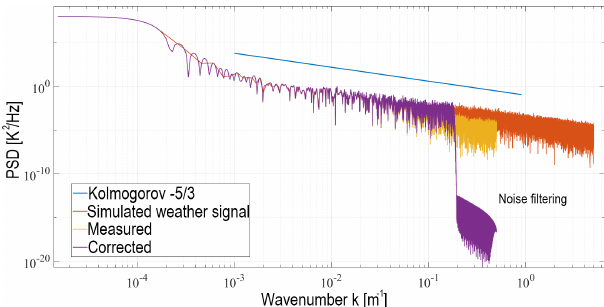
Figure 8. Power spectral density of the simulated weather signal in CBL conditions and processed signals using the sensor models. Results from before and after applying the IDMP are shown.